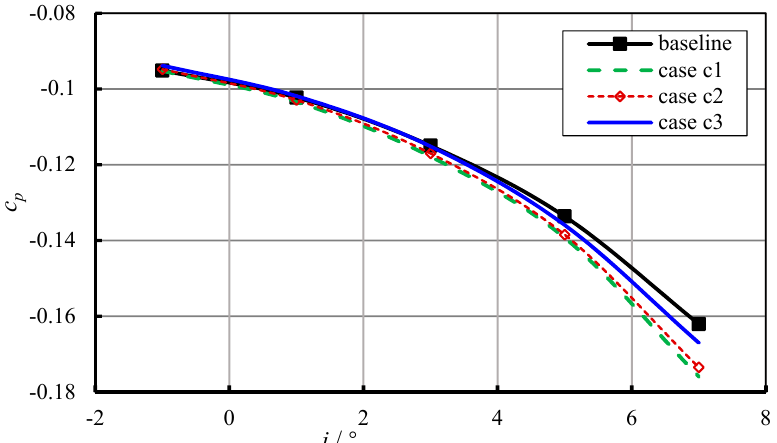
( c ) Figure 8. The geometry of the end wall contouring cases: ( a ) case c1; ( b ) case c2; ( c ) case c3. Figure 9 gives the variation of the overall total pressure loss ( c p ) with incidence ( i ) for the three end wall contouring cases. The working condition with i = − 1° is the design point.